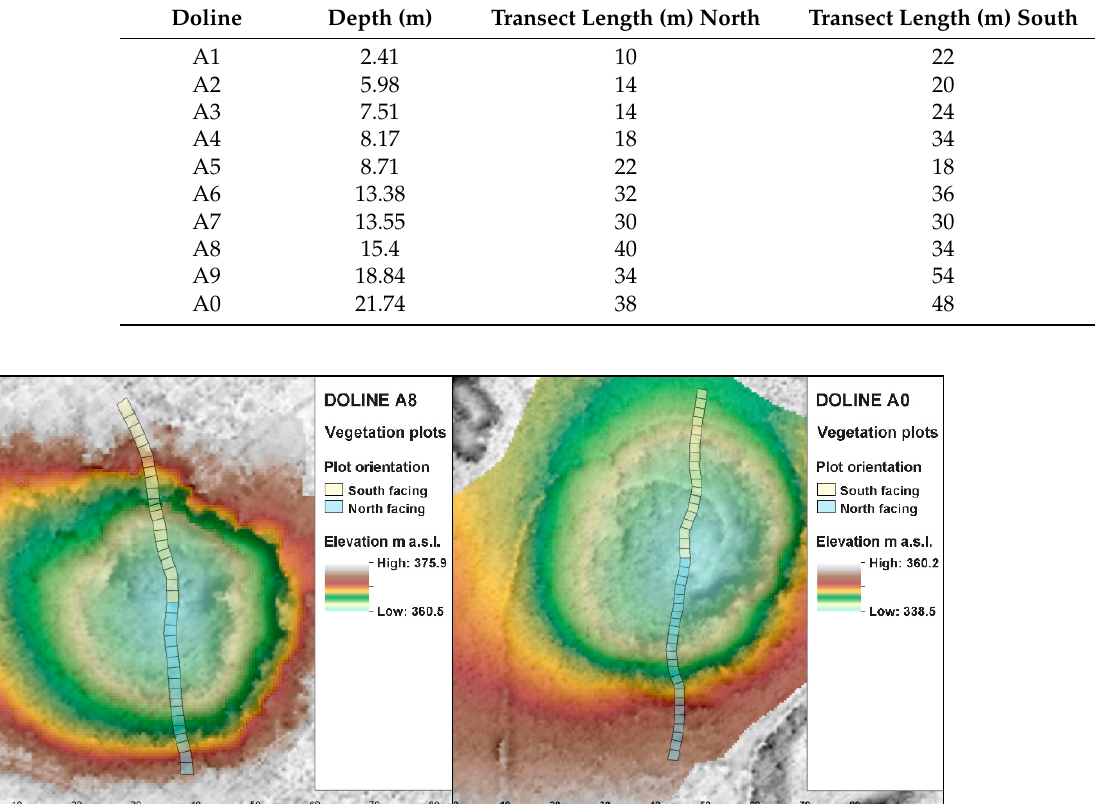
Table 1. Selected dolines of different depth. The length of the transect from center to the northern and southern edge of doline is presented.